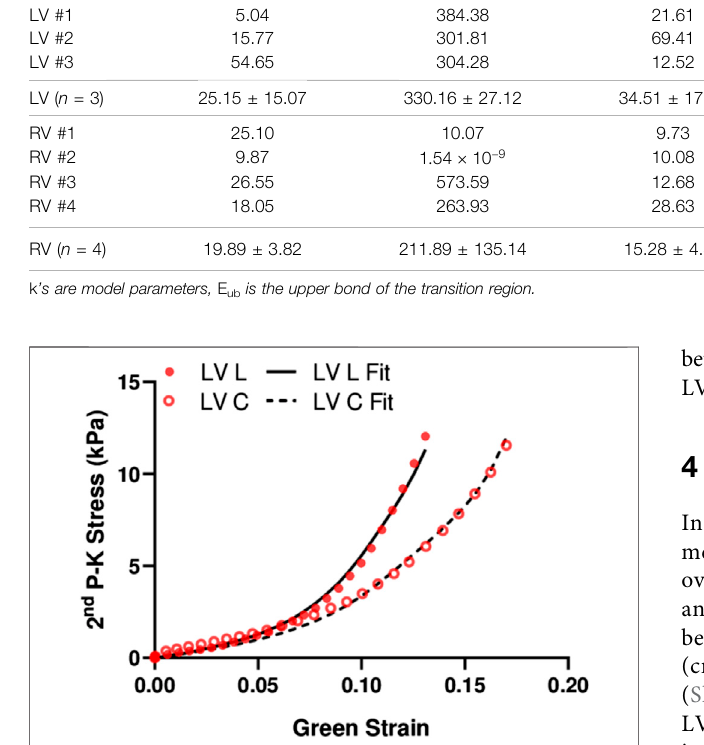
FIGURE 6 | Representative fi tting results using the structurally informed